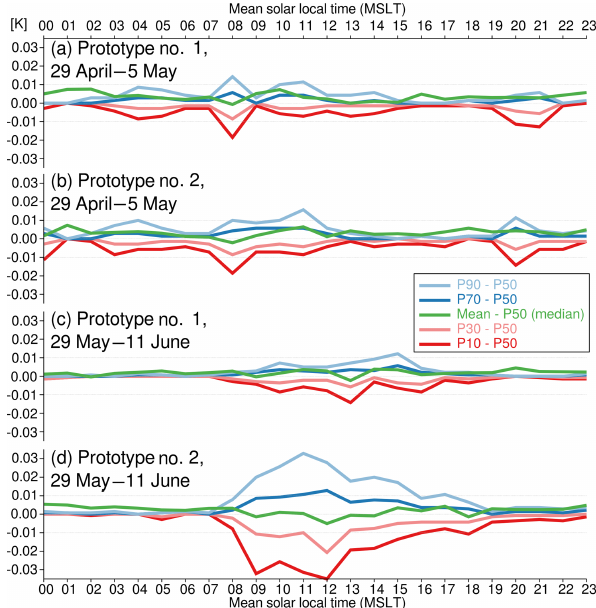
Figure 11. Average SST diurnal cycle observed by the two SVP- BRST prototypes’ HRSST sensors, during time periods A and B defined in Fig. 9. For each panel, the reference is the mean SST at 00:00UTC. Horizontal thin dotted lines indicate zero.